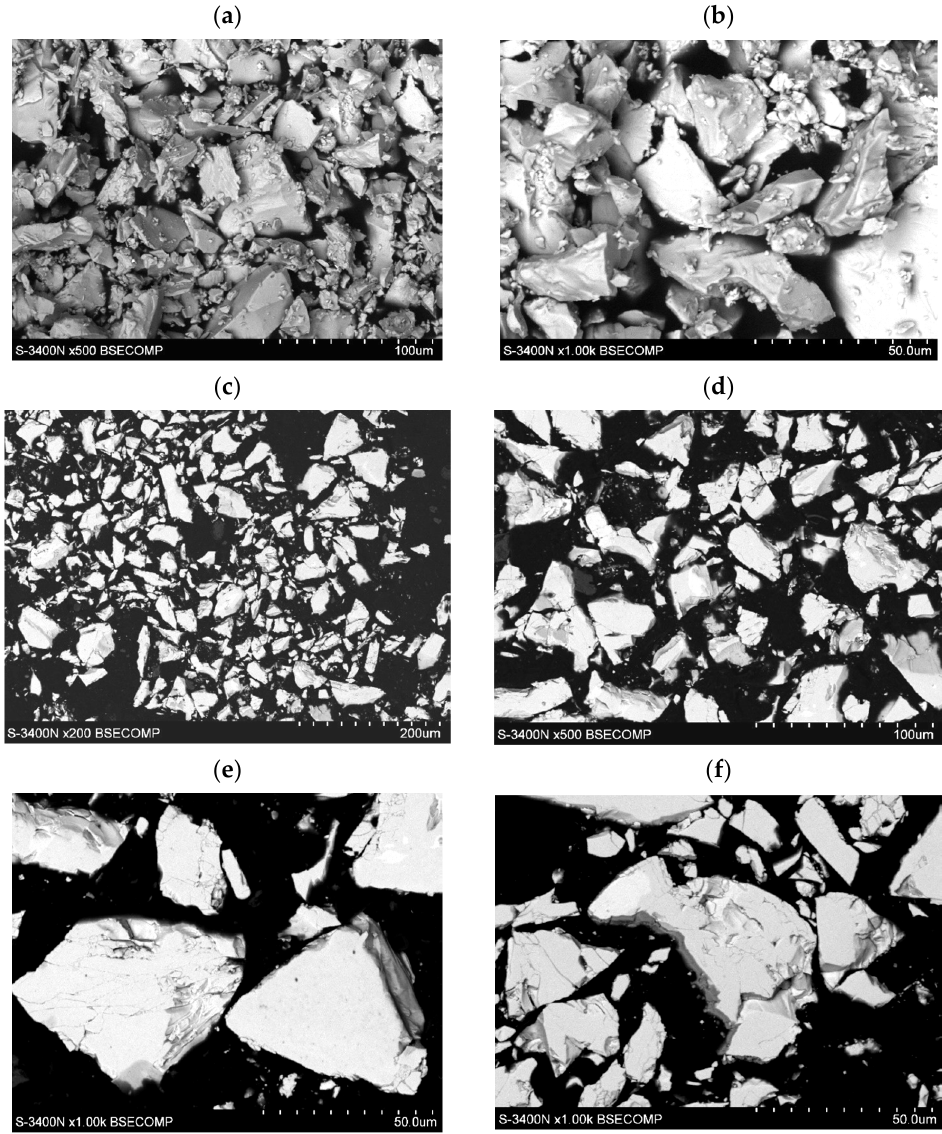
Figure 1. Evolution of morphology of the LaNi 4.5 Co 0.5 particles: ( a , b ) before modification, ( c – f ) after coating with a TiCrFeCoNi layer of the applied HEA.